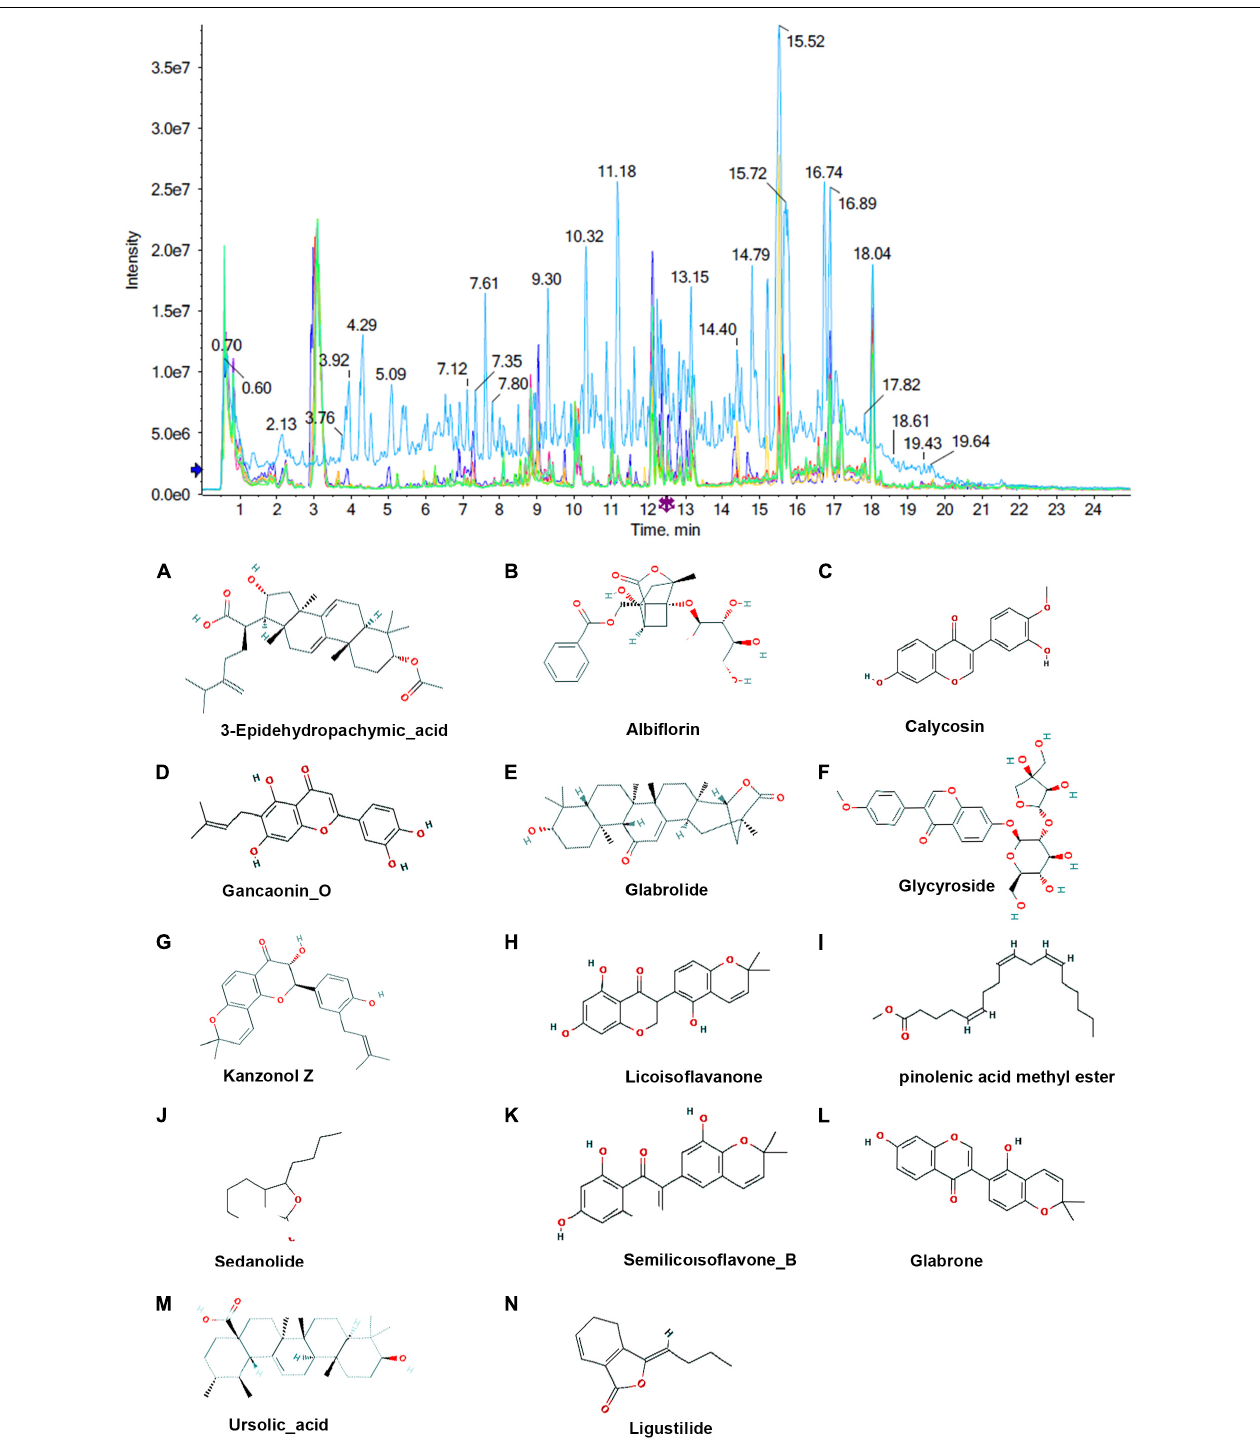
FIGURE 5 | Chromatograms and chemical structures of MBP metabolites in the transitional milk of sows after dietary supplementation of MBP. The chromatograms in positive mode. (A–N) Absorbed milk components 3-Epidehydropachymic_acid, Albiflorin, Calycosin, Gancaonino, Glabrolide, Glycyroside, Kanzonol z, Licoisoflavanone, pinolenic acid methyl ester, Sedanolide, Semilicoisoflavone_B, Glabrone, Ursolic_acid and Ligustilide.